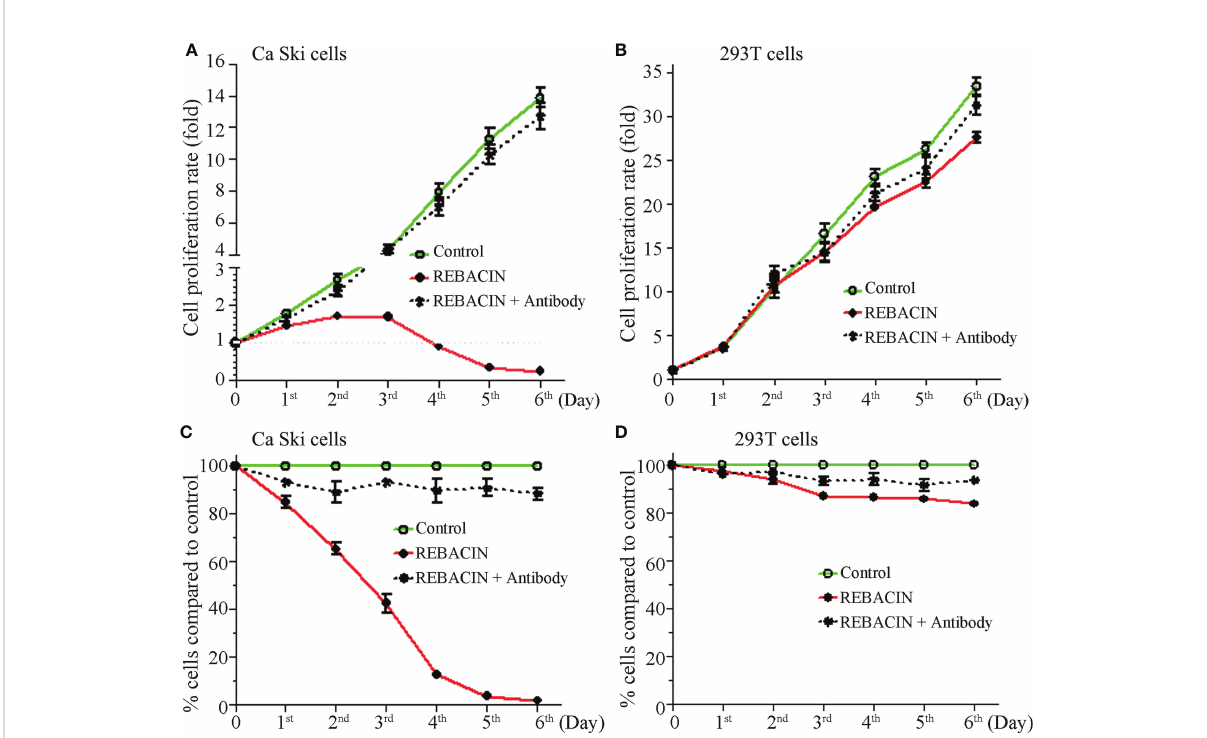
FIGURE 2 Effect of REBACIN ® on the growth of different cell lines. Ca Ski (A, C) or 293T (B, D) cells in 24-well plate were treated or not treated by 50 m g/ ml REBACIN ® or REBACIN ® /anti-REBACIN ® antibody for up to 6 days, and the total amount of alive cells in each well was counted every 24 hours. During each count, the cell proliferation rate at the beginning stage was set as 1 (A, B) ; the total alive cells in each well without any treatment (control) were set as 100%, and the total alive cells in treated well were normalized to its control (C, D) . Data show mean ± SEM of seven independent experiments. REBACIN ® versus control: p < 0.05 in (A) and p < 0.01 in (C)